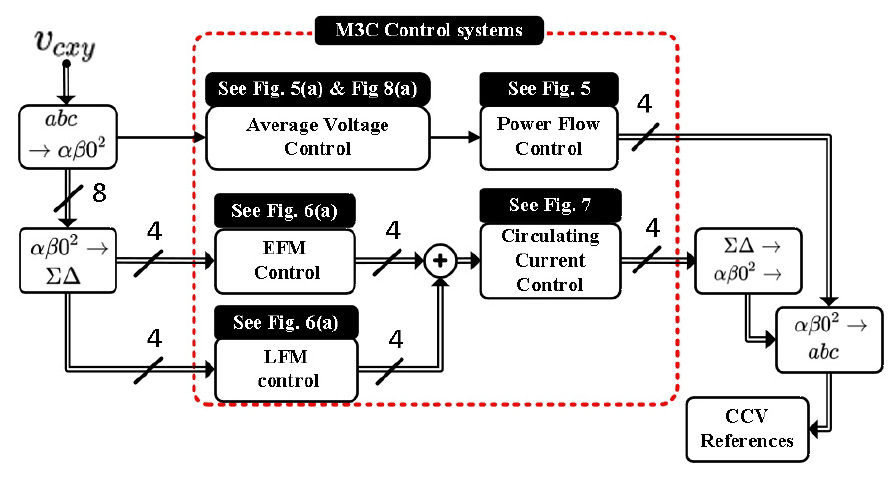
Figure 4. Control system for the M 3 C .